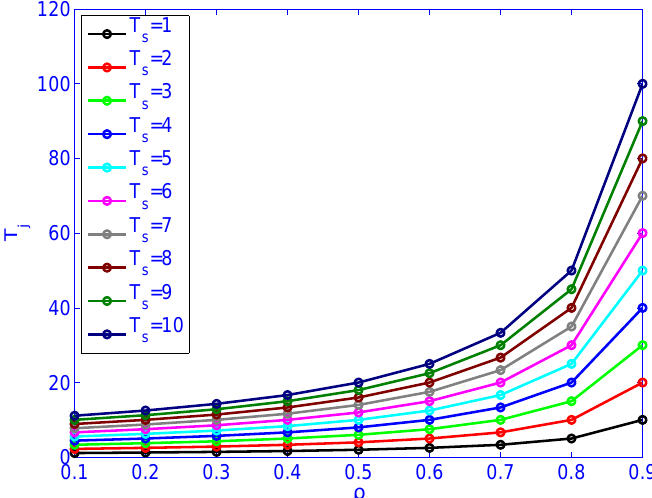
Figure 9. The impact of load ( ρ ) and service rate ( T s ) on job latency T j